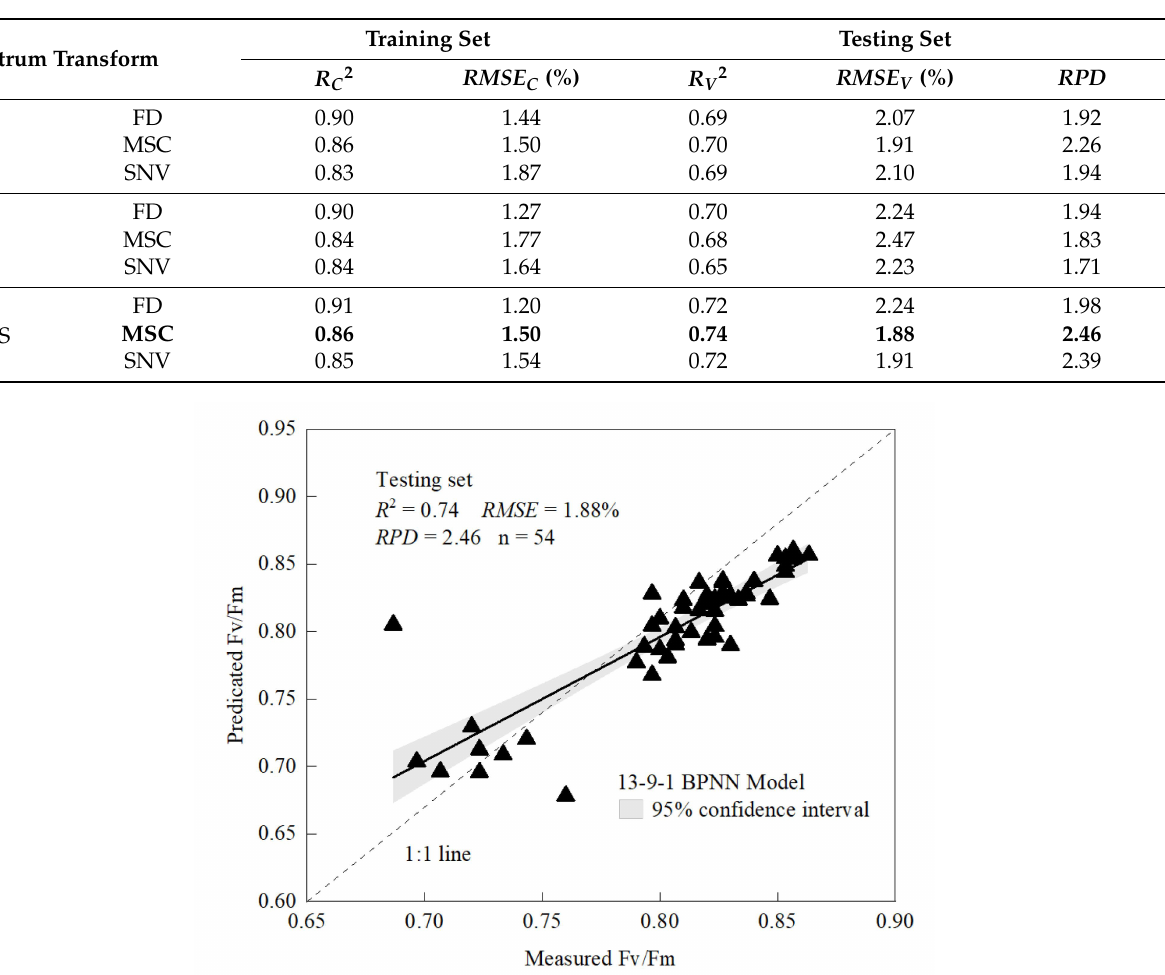
Table 5. Model construction and evaluation.